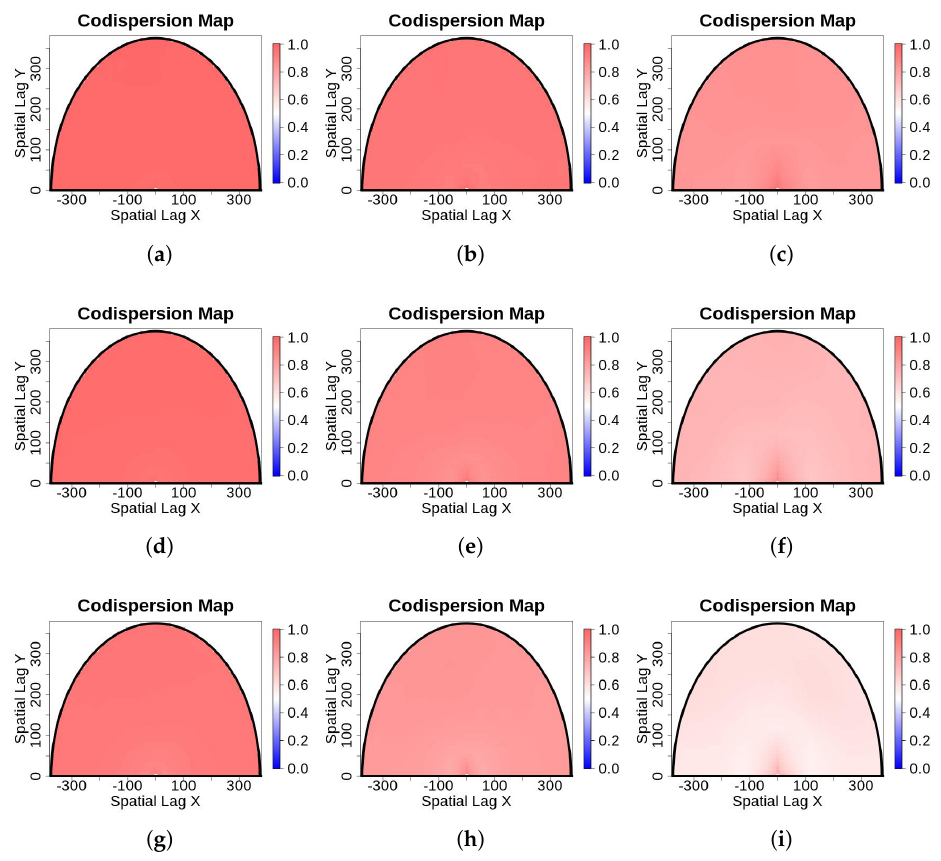
Figure 9. Codispersion map between the reference Figure 1a and the images contaminates with missing observation at random locations depicted in Figure 3a–i. Images ( a )–( i ) show how the correlation decreases when the missing block size